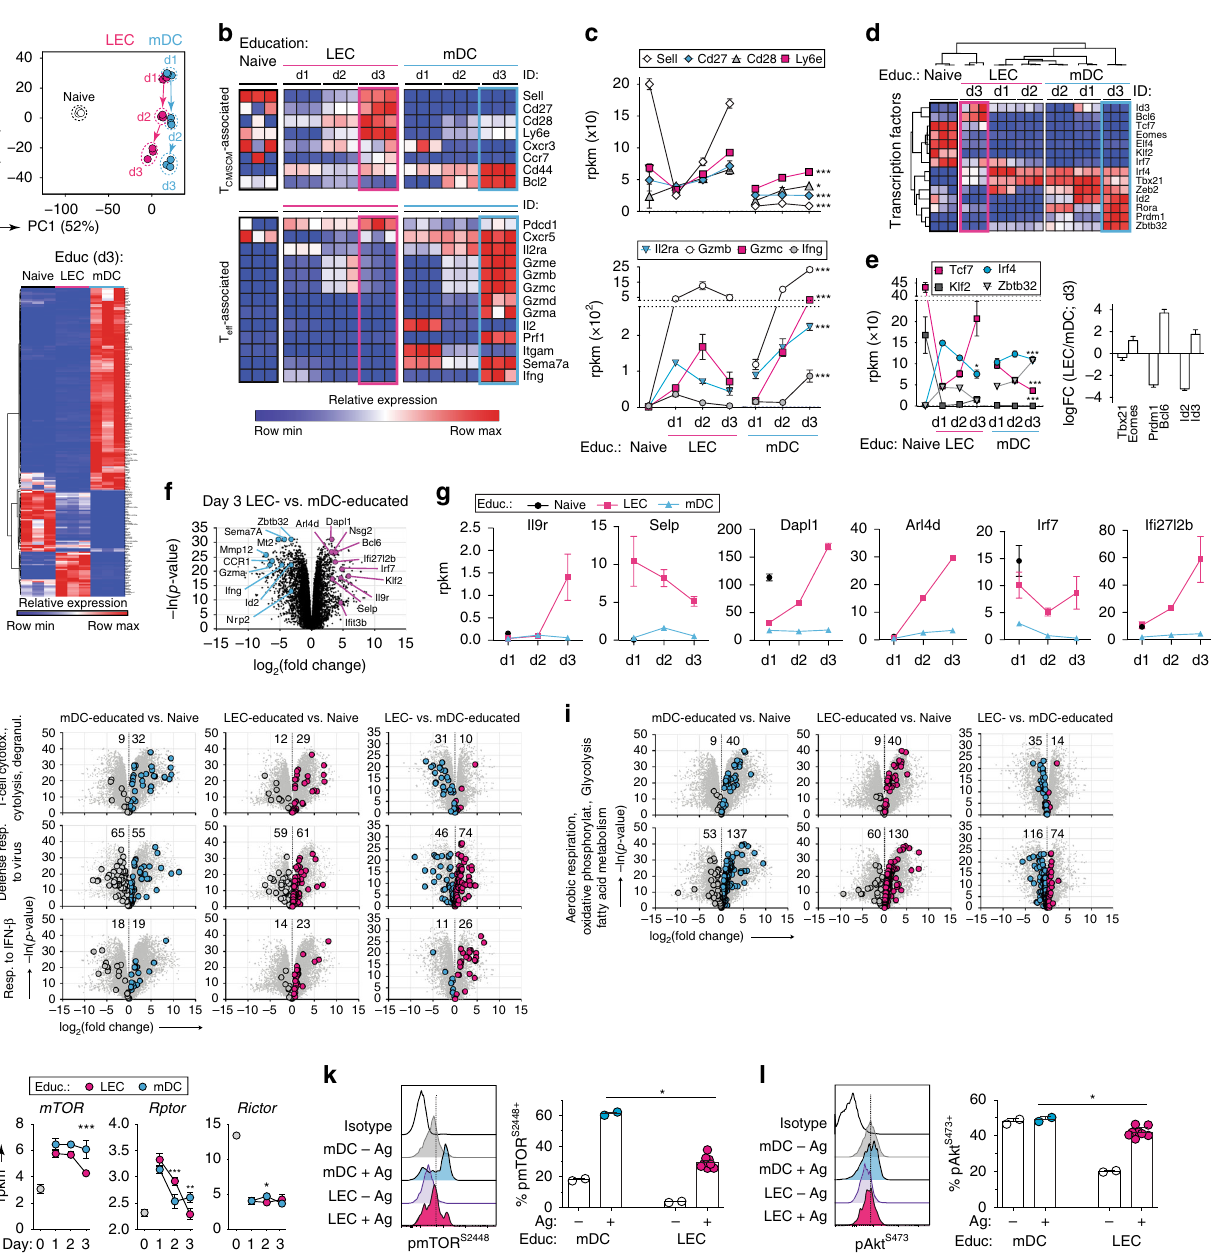
Fig. 5 Transcriptome and metabolic signaling in LEC-educated CD8 + T cells is consistent with T CM /T SCM -like phenotype. Naïve OT-I cells were educated in the presence of antigen by LECs or mDCs for up to 3 days and subsequently analyzed by RNA sequencing. Resting naïve OT-I cells have been shown for comparison. a (top) Principal component analysis (PCA) of most-modulated genes across time and APC type suggest PC1 (52% of variance) includes genes related to antigen experience and APC type, whereas PC2 (18% of variance) contains genes related to the effects of time. (bottom) Heatmap depicting the most signi fi cant differences in gene pro fi les following 3 days of education by LECs or mDC, fi ltering for changes in expression (|log 2 FC|>2.89) between mDC/LEC-educated CD8 + T cells and p <0.01. b Heat maps depicting normalized expression levels of various memory-associated and effector-associated genes on OT-I cells according to co-culture condition and time. Each column represents data originating from a single biological replicate. c Normalized expression (rpkm; reads per kilobase per million mapped reads) of selected genes over time, comparing effects of LEC vs. mDC education. d Unsupervised hierarchical clustering analysis to identify dynamics of gene expression encoding TFs regulating effector/memory differentiation. e (left) Normalized expression of genes encoding TFs related with memory ( Tcf7, Klf2 ) versus effector ( Irf4, Zbtb32 ) differentiation. (right) Log fold-change in expression of indicated transcription factors due to LEC education, relative to mDC education. p <0.001 for all except Tbx21 ( p <0.01). f Volcano plot highlighting most-modulated genes following LEC education (magenta) or mDC education (blue), and g kinetics of normalized expression of selected genes. h , i Pairwise-comparison of transcriptomes as volcano plots highlighting sets of genes linked to speci fi c biological processes, as annotated on the Gene Ontology Atlas 47 . i Volcano plots for genes associated with anabolic (glycolysis) and catabolic processes (oxidative phosphorylation, aerobic respiration, and fatty acid oxidation). j Normalized gene expression (rpkm) of genes encoding the central mediators of the mTOR-signaling pathway, including components of the mTORC1 ( Rptor ) or mTORC2 ( Rictor ) complexes. k , l SIINFEKL-pulsed LECs or mDCs were co-cultured with naïve OT-I cells for 2h in vitro, and phosphorylated k mTOR S2448 and l Akt S473 was quanti fi ed on OT-I by intracellular fl ow cytometry. Data points and error bars indicate mean±SD of n = 3 biological replicates a – j or n = 2 – 8 technical replicates k , l . * p ≤ 0.05, ** p ≤ 0.01, *** p ≤ 0.001 via one-way ANOVA with Benjamini – Hochberg correction for false discovery rate